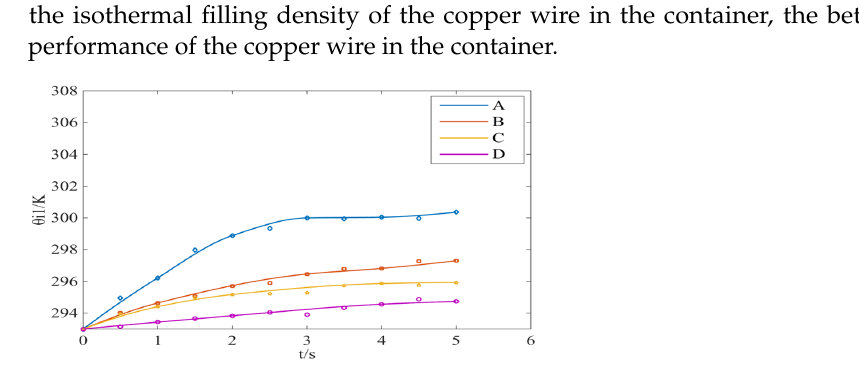
Figure 9. Temperature variation of the isothermal container inflation process under different filling densities.